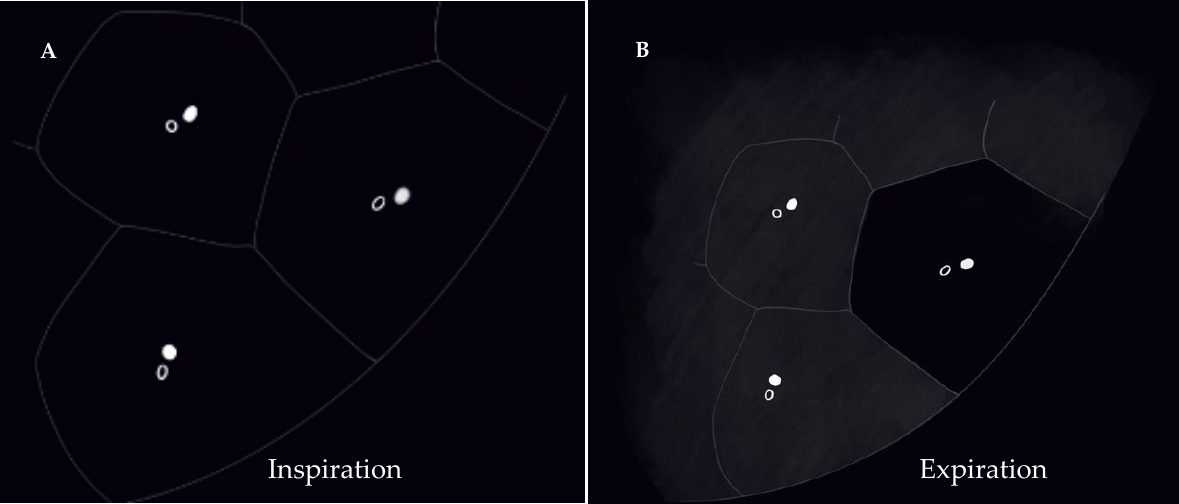
Figure 3. Pictorial representation of heterogeneous lung attenuation patterns at the level of the secondary pulmonary lobule. Top panel shows expected appearance on inspiratory images and the bottom panel shows changes in lung parenchymal density on expiratory images. Notice that mosaic perfusion can be seen with primary vascular disease and small airway disease, with change in lobule size being the differentiating feature.